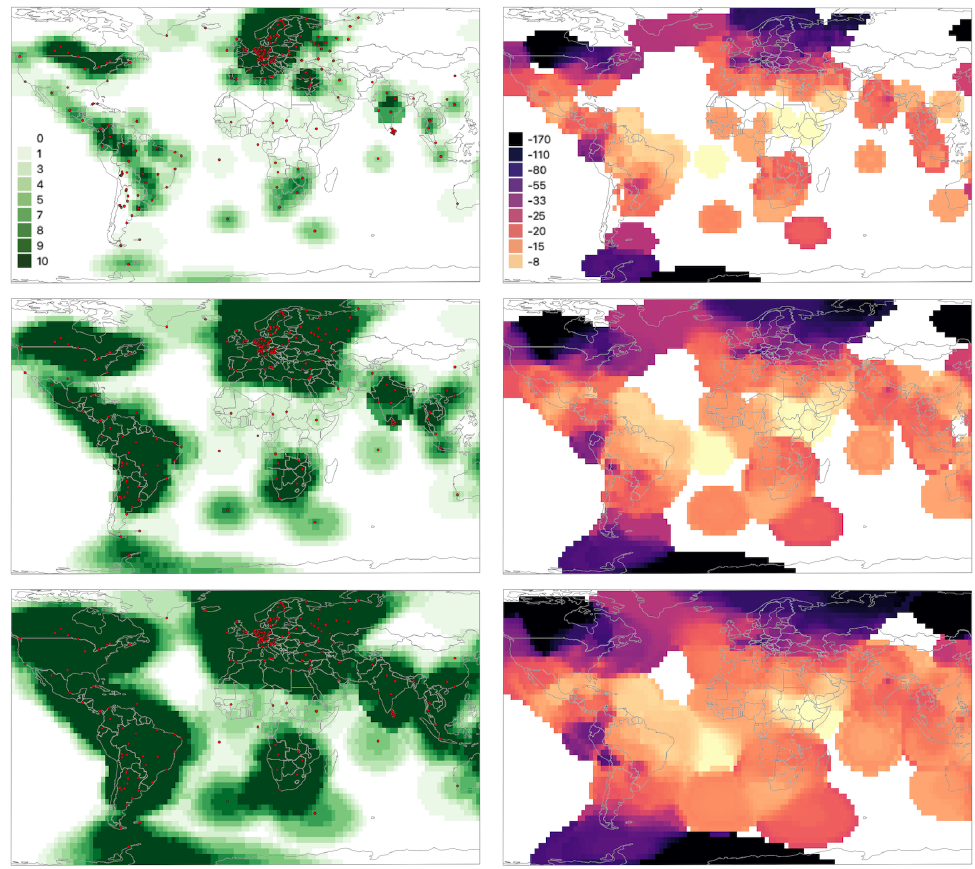
Figure 19. Three sheets of the Timescape model, time increasing top to bottom (year 1981, 1985, and 1989). ( Left ): Causal neighborhood η ( x ) , source events’ sites are shown as red dots. ( Right ): field values (cid:98) Φ ( x ) , note the typical bull’s eye shapes due to the IDW